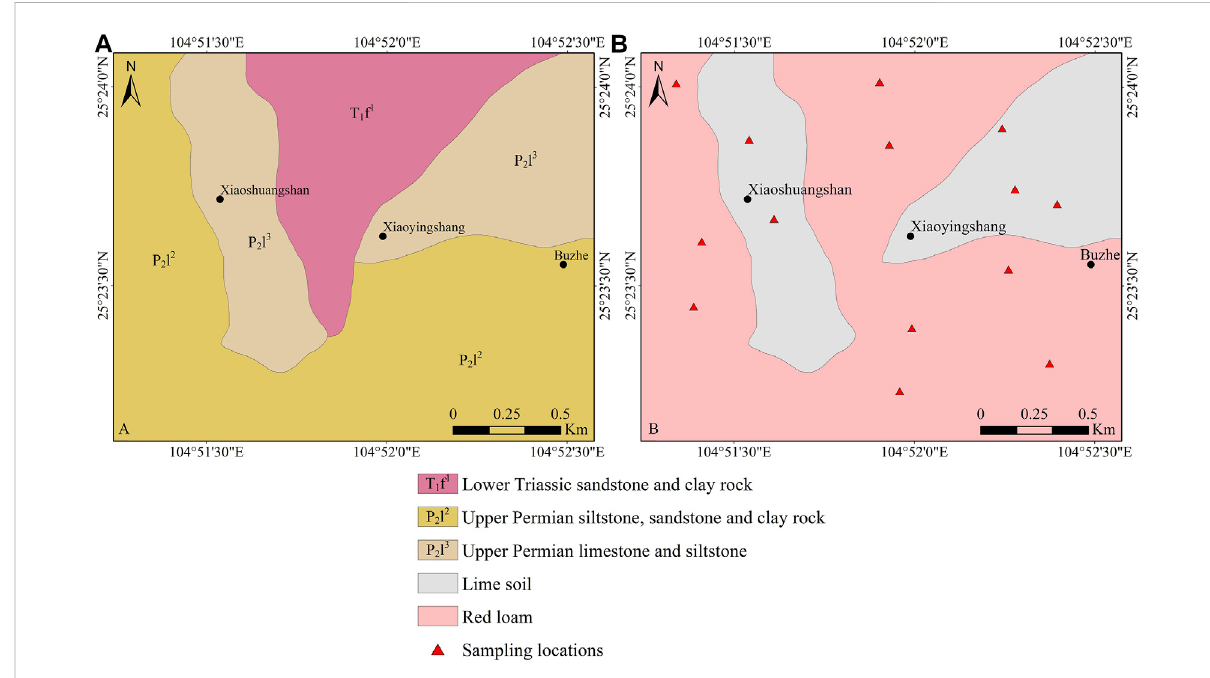
FIGURE 2 (A) Geology map of the study area and (B) spatial distribution of soil types.